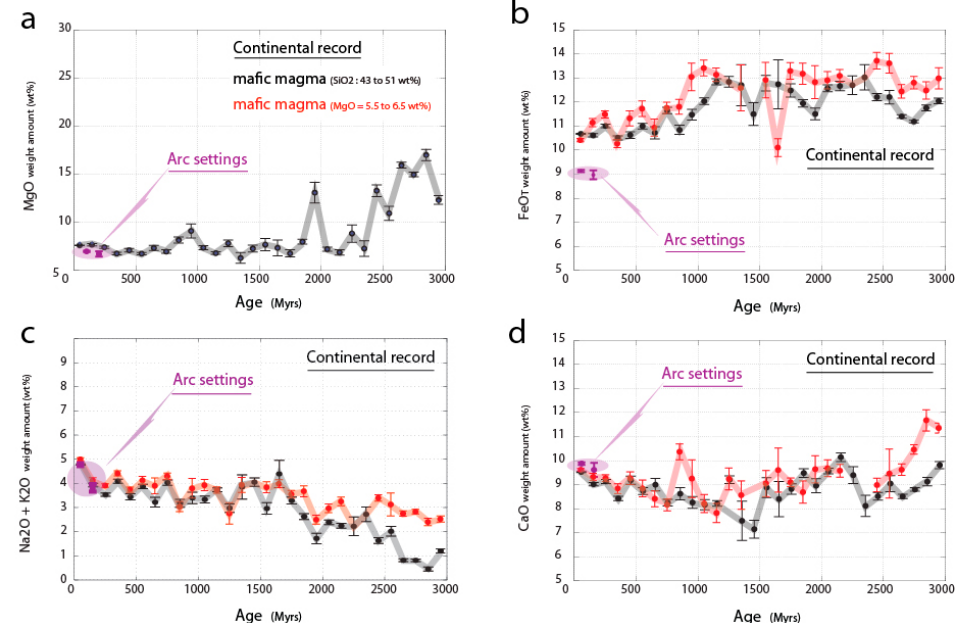
Figure 5. ( a-d ) Range of compositions (FeO T , CaO, Na 2 O + K 2 O and MgO wt%) for mafic magmas (43 < SiO 2 < 51 wt%) sampled around the world (>22,000 samples of lava, continental s.l. record) and statistical assessment of the averaged-values evolution through time (black drawbars; uncertainty bars correspond to ±1 σ standard deviation for age step of 100 Myrs). Whatever the range of composition considered for mafic magma (Si 43–51 or Mg 06 ), the temporal trends appear broadly similar. ( b ) A divergence in FeO T (wt%) between mafic magmas (43 < SiO 2 < 51 wt%) sampled in recent (<200 Ma) arc-settings (GEOROC information) and the global systematics for continental s.l. mafic magma is observed. Such discrepancy is consistent with a more marked calc-alkaline evolution for mafic magma in arc setting, involving Fe depletion through mineral fractionation in the lithospheric